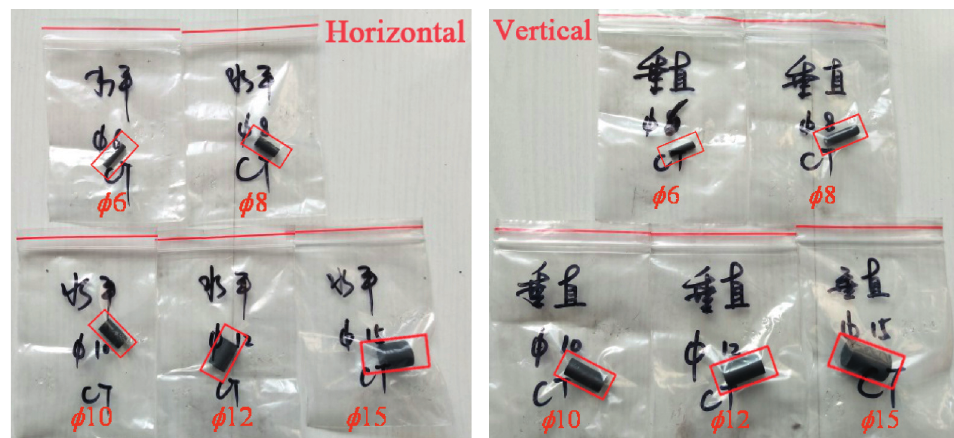
Figure 1: The shale sample images with different bedding directions.